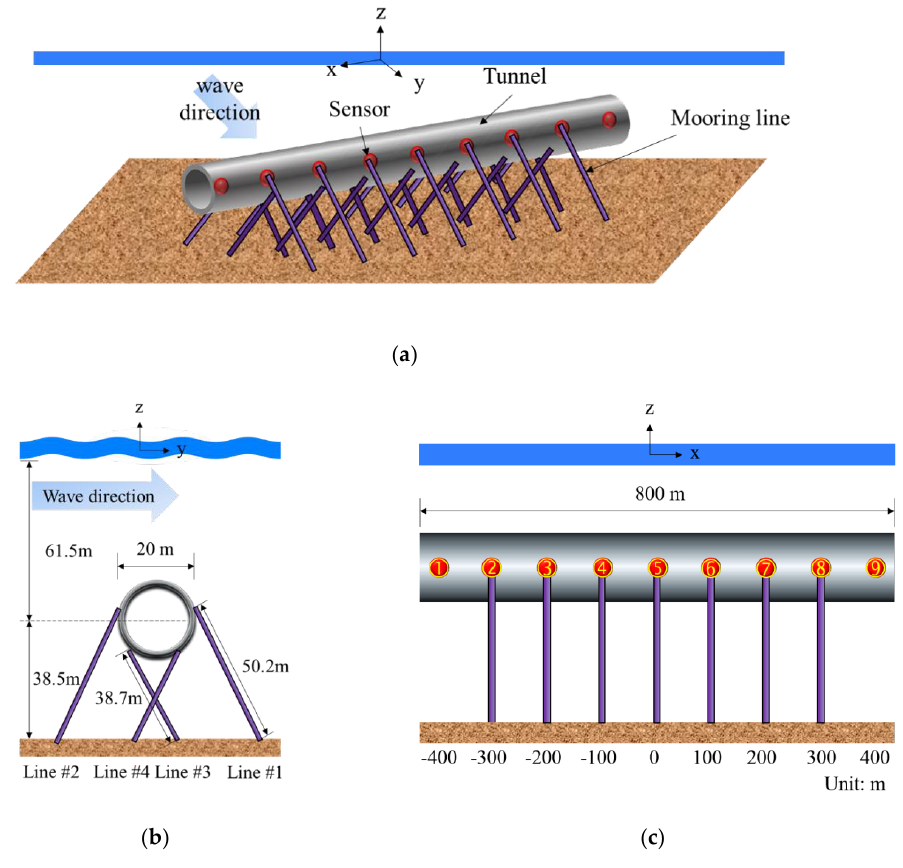
Figure 1. 2D and 3D schematic drawings (accelerometers are marked with red dots in ( a ); mooring line numbers are given in ( b ); sensor numbers (1–9) are given in ( c )). Table 1. Design parameter of the SFT ( E is Young’s modulus, I is area moment of inertia, A is cross-sectional area).